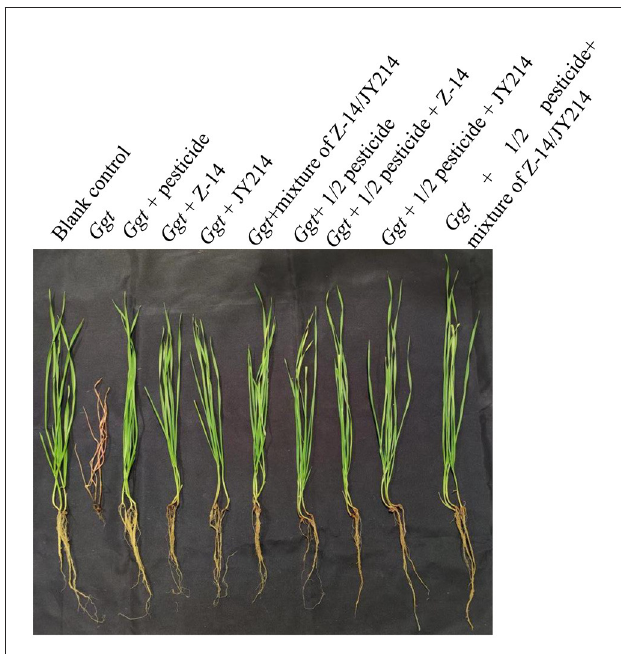
FIGURE8 Control effect of pesticide, Z-14, JY214, and their combinations on wheat take-all disease. These treatments were conducted in the greenhouse.